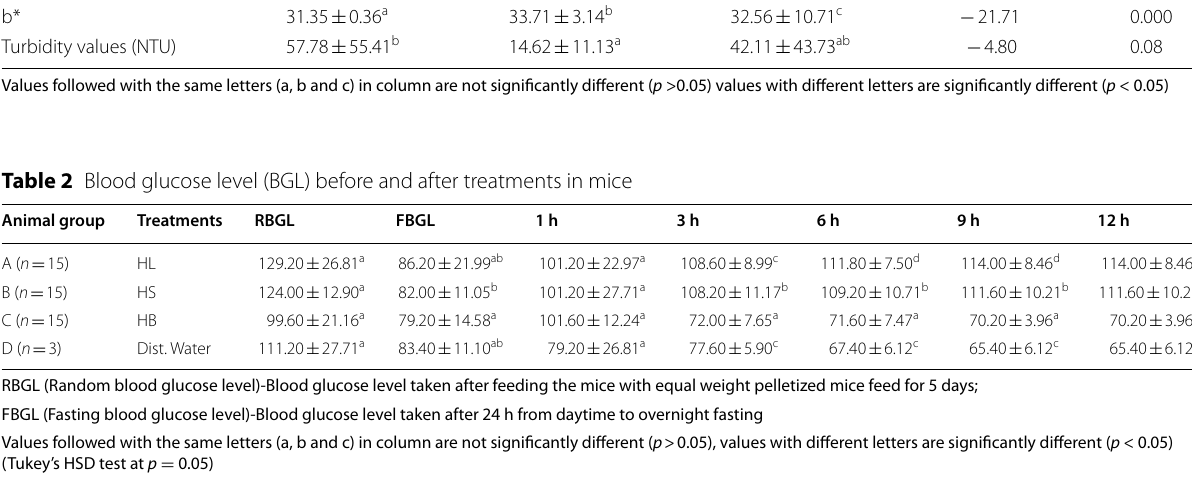
Table 1 Turbidity and color properties of the honey samples Properties/Group HB HS